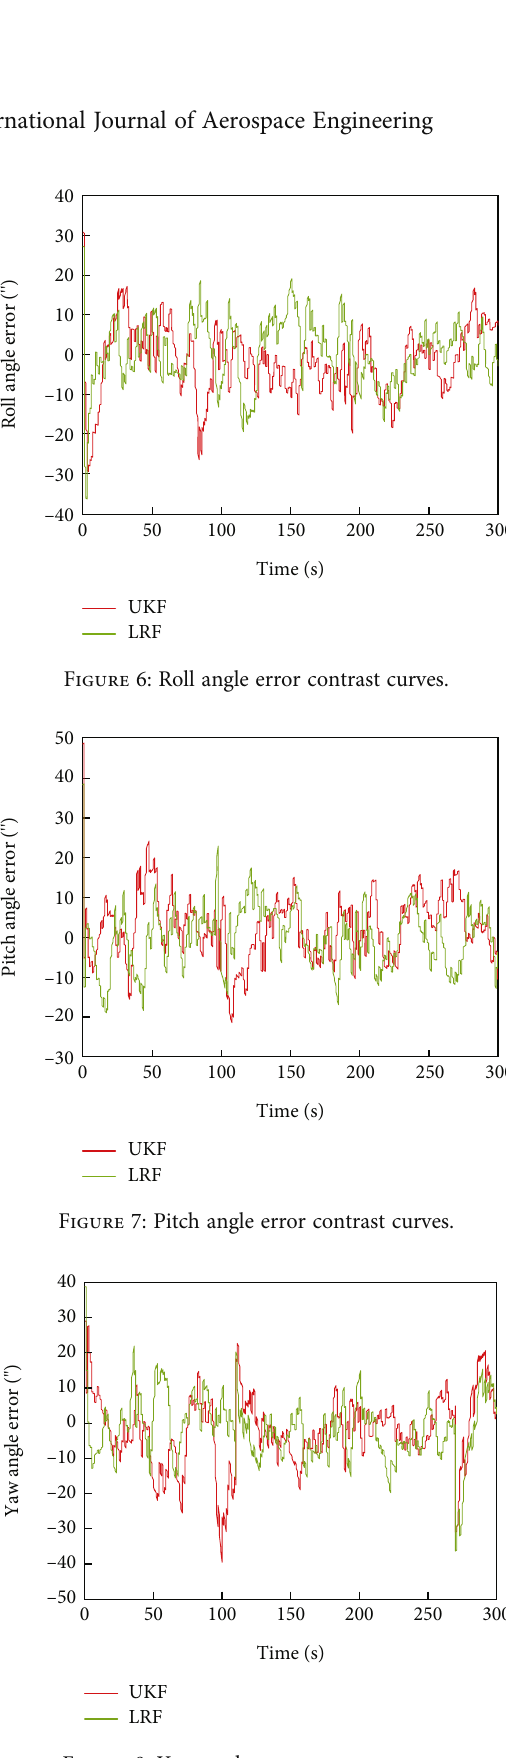
Figure 8: Yaw angle error contrast curves.